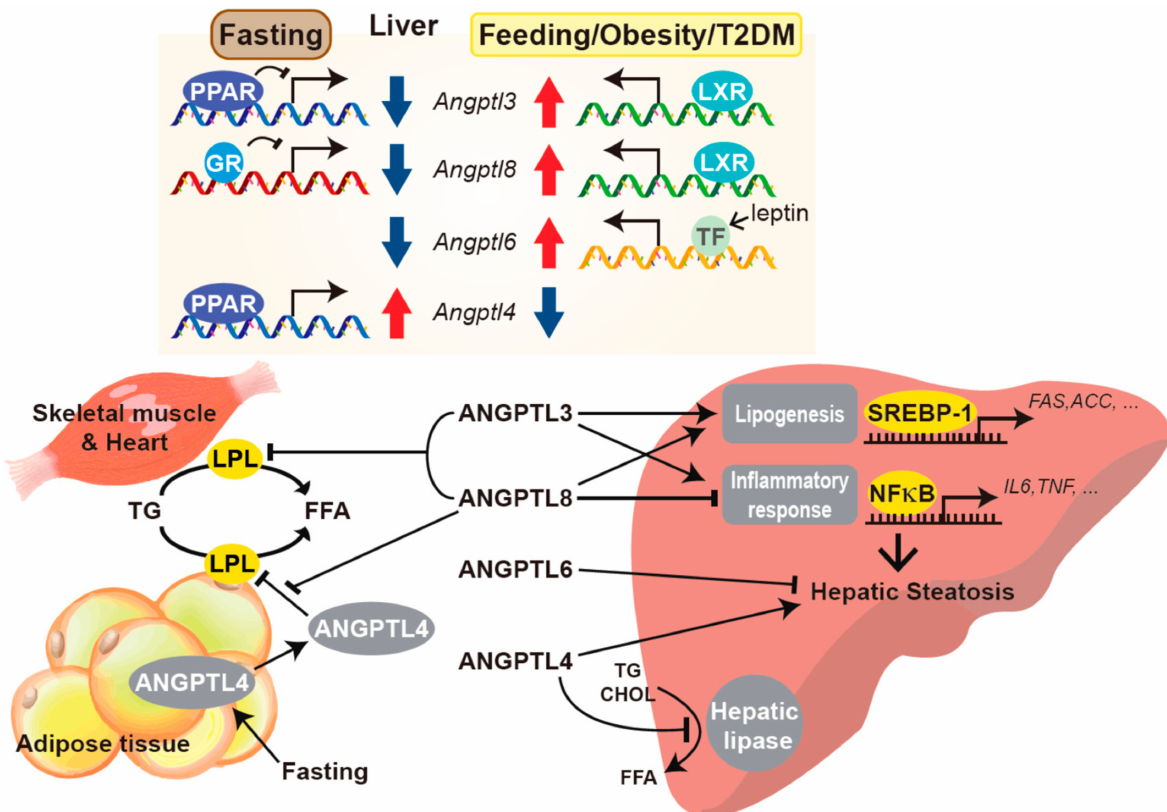
Figure 1. The role of ANGPTL family proteins in lipid metabolism in the liver and non-hepatic tissues. ANGPTL family proteins are hepatokines primarily produced and secreted by the liver, regulating various cellular processes, including lipid metabolism, within as well as outside the liver. The upper panel presents the transcription factors that regulate the gene expression of ANGPTL members under fasting or feeding/obesity/type 2 diabetes (T2DM) conditions. The transcription of ANGPTL3, ANGPTL8, and ANGPTL6 is upregulated by liver-X-receptor (LXR) activation or leptin signaling following feeding or under metabolic disorders, such as obesity and type 2 diabetes mellitus (T2DM), while peroxisome proliferator-activated receptor (PPAR) and glucocorticoid receptor (GR) suppress the transactivation of ANGPTL3 and ANGPTL8 under fasting conditions, respectively. Circulating ANGPTL proteins then serve as lipoprotein lipase (LPL) inhibitors in non-hepatic tissues, while liver-derived ANGPTL4 inhibits hepatic lipase, resulting in decreased triglyceride clearance. Therefore, ANGPTL proteins contribute to the development of hepatic steatosis by regulating lipogenesis and/or the inflammatory response, as depicted above. ACC: Acetyl-CoA carboxylase; CHOL: Cholesterol; FAS: Fatty acid synthase; FFA: Free fatty acid; IL6: Interleukin-6; NF-kB: Nuclear factor kappa-light-chain-enhancer of activated B cells; SREBP: Sterol regulatory-element binding protein; TF: Transcription factor; TG: Triglyceride; TNF: Tumor necrosis